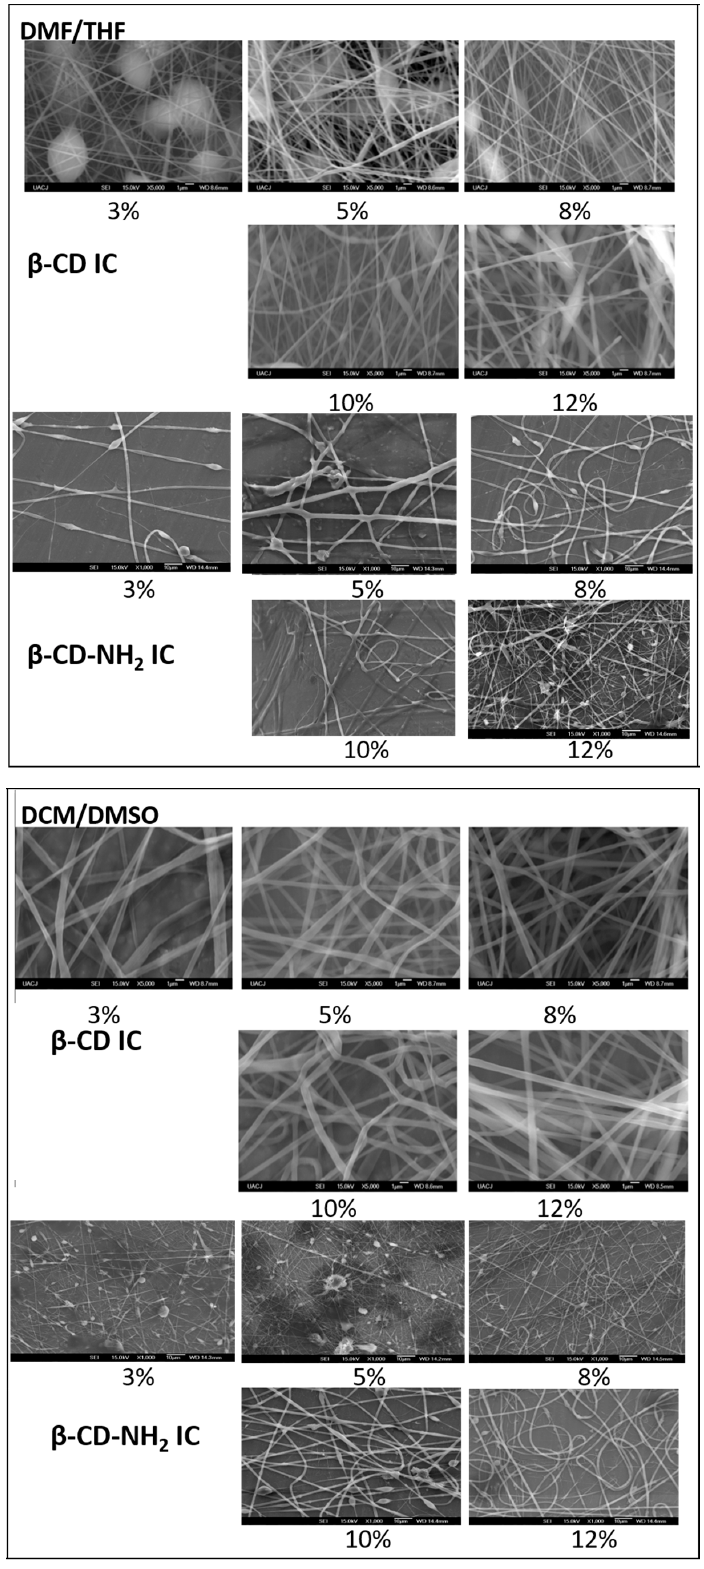
Figure 10. Electrospinning optimization process, with different concentrations of β -CD/PCL and β -CD-NH 2 /PCL using two solvent mixes: DMF/THF ( top ) and DCM/DMSO ( bottom ).